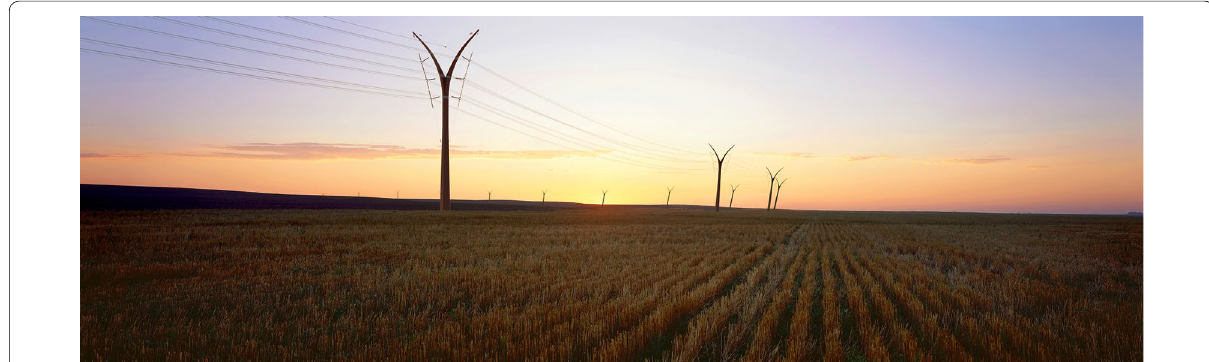
Fig. 28 Germogli pylon. HDA: Pylon Designer. Client: Terna. Competition Team: Hda, Rosenthal. Contractor: Tecnopali. Hda Team: Maria Angela Corsi (Competition Project Leader), Carla Zaccheddu, Francesco Cingolani, Pier Luigi Bucci, Gaëtan Kohler. Date: 2009–2013 (from http://www.hda-paris